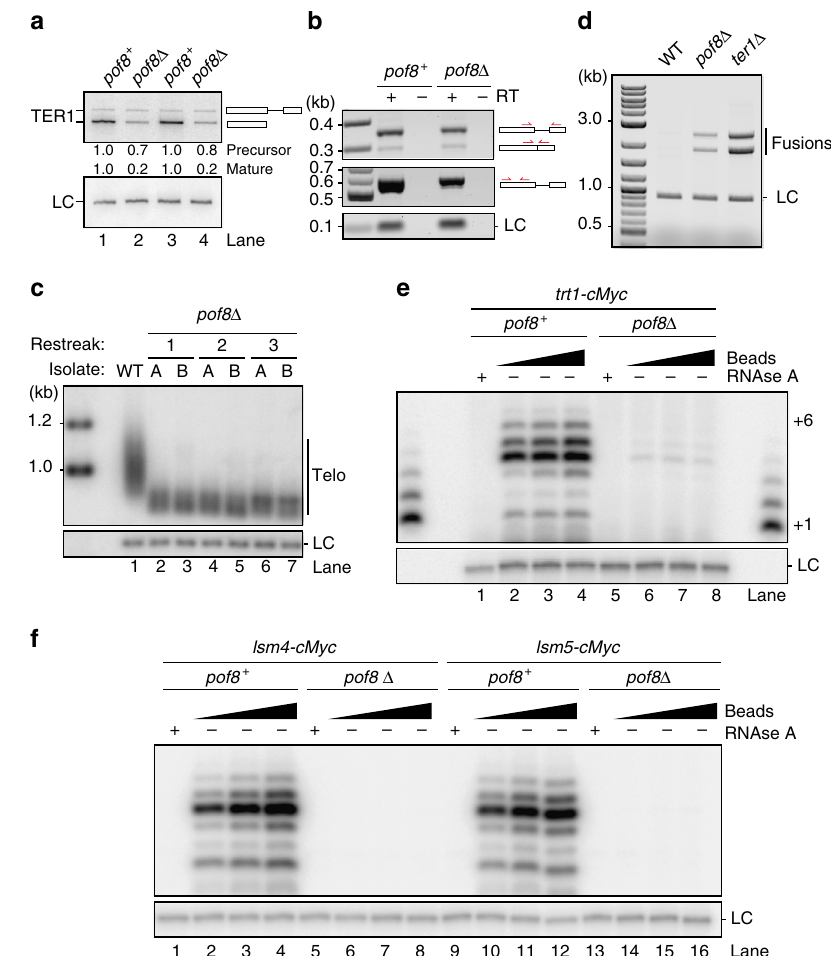
Fig. 2 Telomerase and telomere defects associated with the deletion of pof8 . a Northern blot analysis of TER1 from wildtype and pof8 Δ strains following RNaseH cleavage. Quanti fi cation of TER1 signal relative to wildtype and normalized to the loading control (LC, snR101) is shown below the fi gure. Lanes 1 and 3 represent independent isolates for pof8 + , and lanes 2 and 4 for pof8 Δ . The schematics on the right represent TER1 precursor and mature forms. Uncropped blots are presented in Supplementary Fig. 3a. b RT-PCR ampli fi cation of spliced and unspliced TER1 (top panel), total TER1 (middle panel), and snRNA U1 used as loading control (LC, lower panel). The schematics on the right indicate the position of primers used relative to the structure of precursor, spliced and cleaved TER1 (RT reverse transcriptase). c Southern blot analysis to compare telomere length from wildtype (WT) and pof8 Δ cells. Two independent isolates of pof8 Δ (A and B) were restreaked three times and telomere length was analyzed (one restreak = 20 – 25 generations). The rad16 + locus was probed as a loading control (LC). Lane numbers are indicated below the blot. Uncropped blot is presented in Supplementary Fig. 3a. d